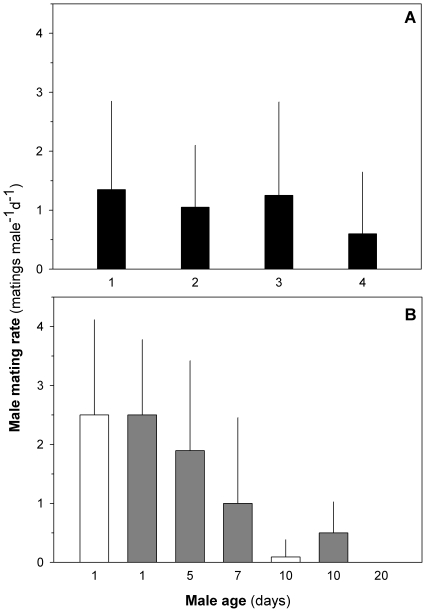
Male mating rates and reproductive lifespan.Mating rates during the first 4 days of male adult life (A). There was no significant temporal trend during this period (Repeated Measures ANOVA Test: F19,3 = 1.4, p>0.1). Mating rates of 1 (control), 5, 7, 10, and day old virgin males (B). Data from the first experiment (1, 10 and 30 day old males) are shown as white bars and data from the second experiment (1, 5, 7 and 10 day old males) are shown in grey. Male mating capacity significantly decreases during the first ten days of reproductive time (Repeated Measures ANOVA Test: F23,2 = 35.7, p<0.001). Mean ± SD. Male age is given relative to time of maturation. We used different cohorts of animals in experiments showed in panel A and B explaining the different mating rates of males younger than 5 days.